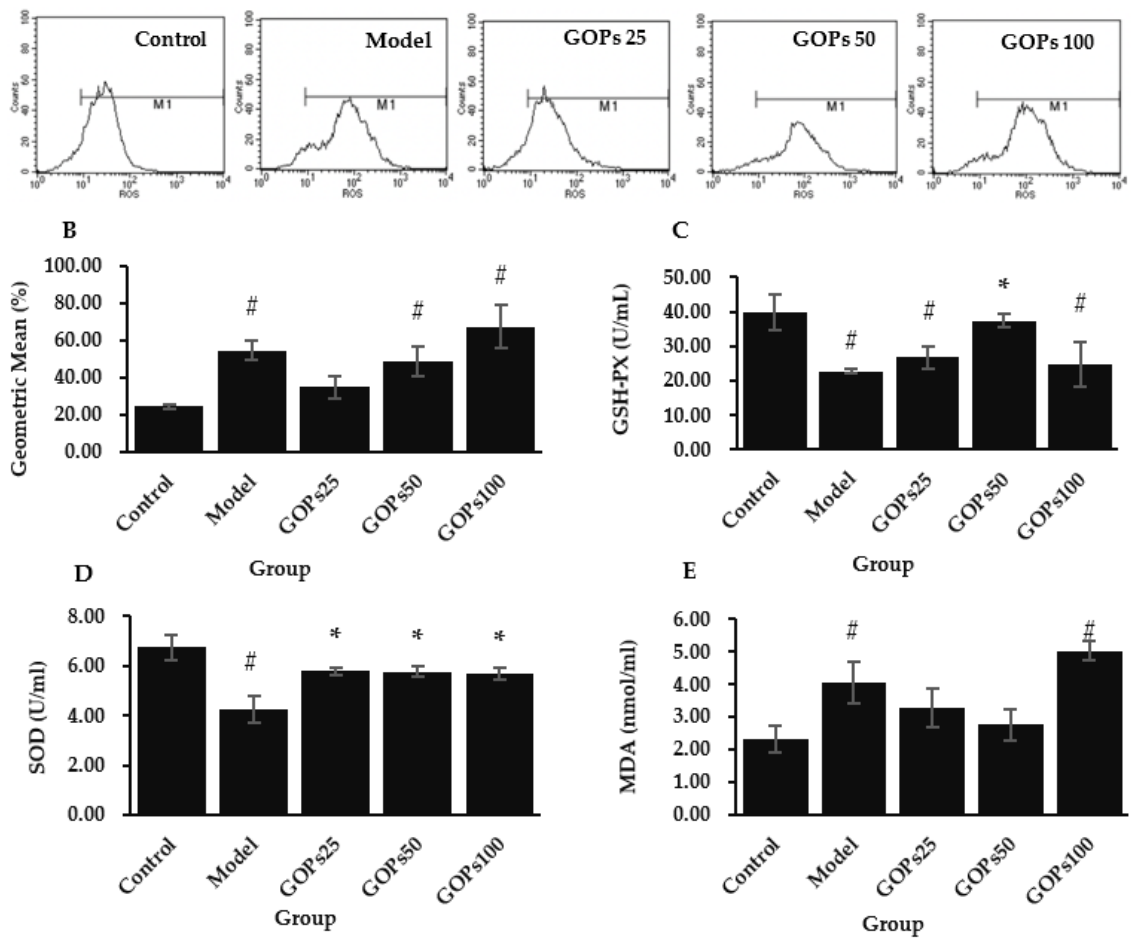
Figure 2. Effect of GOPs on the oxidative stress status of NIH/3T3. ( A ) Effect of GOPs on the fluorescence intensity of reactive oxygen species (ROS). ( B ) Quantitative analysis of ROS fluorescence intensity. ( C ) Effect of GOPs on glutathione peroxidase (GSH-Px) activity. ( D ) Effect of GOPs on superoxide dismutase (SOD) activity. ( E ) Effect of GOPs on malondialdehyde (MDA) levels. Values represent the mean ± S.D. ( n = 3 per group). # p < 0.05 versus control group, * p < 0.05 versus model group.